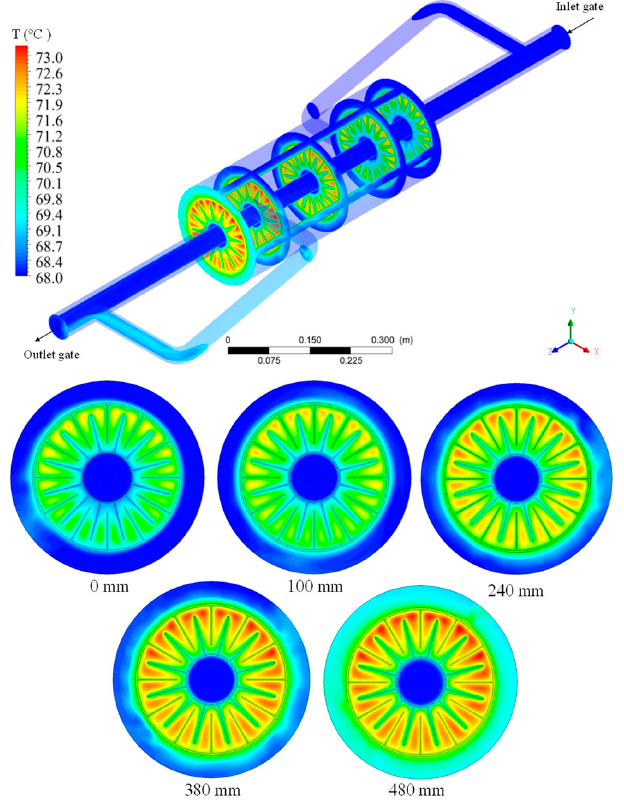
Figure 11. Temperature distribution in TTHX domains for 50% of the PCM in a liquid state (t = 6522 s).